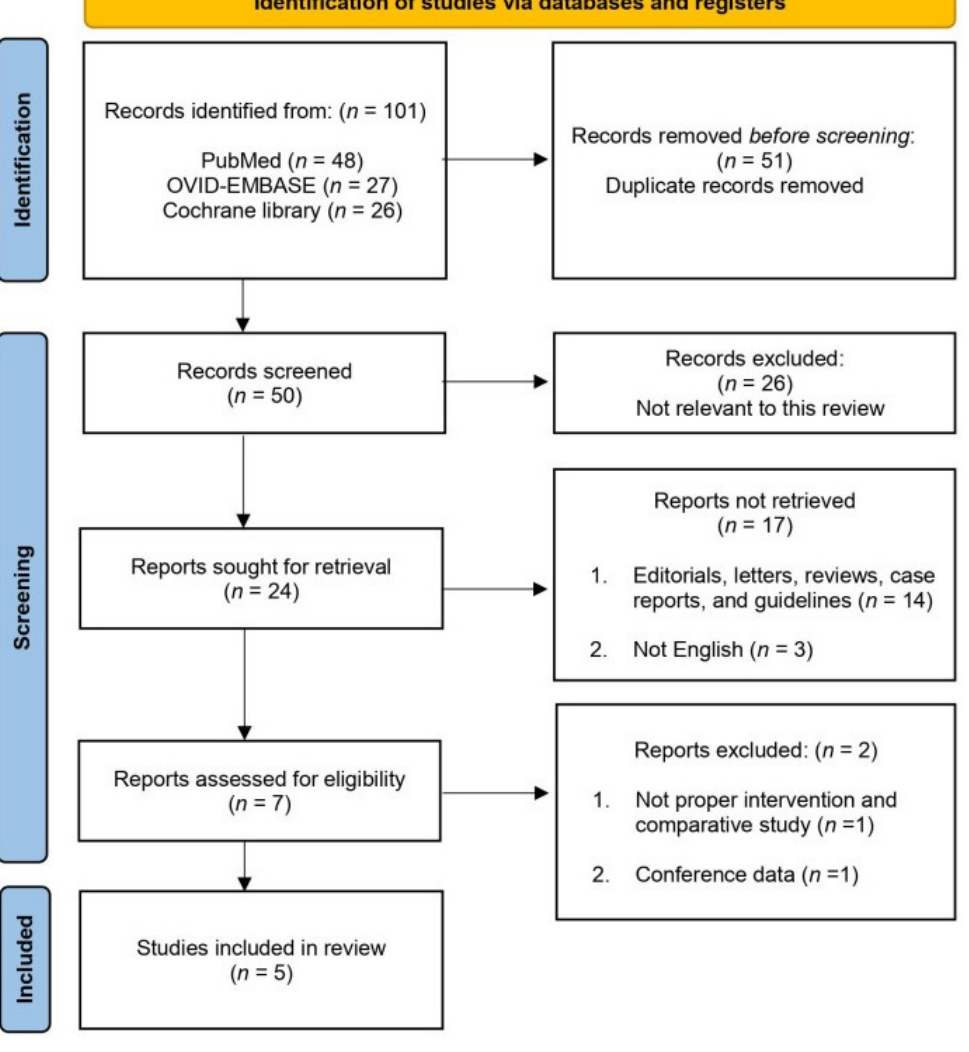
Figure 1. Study selection flowchart according to the Preferred Reporting Items for Systematic Reviews and Meta-Analysis Guidelines. Table 1. Characteristics of the eligible studies.